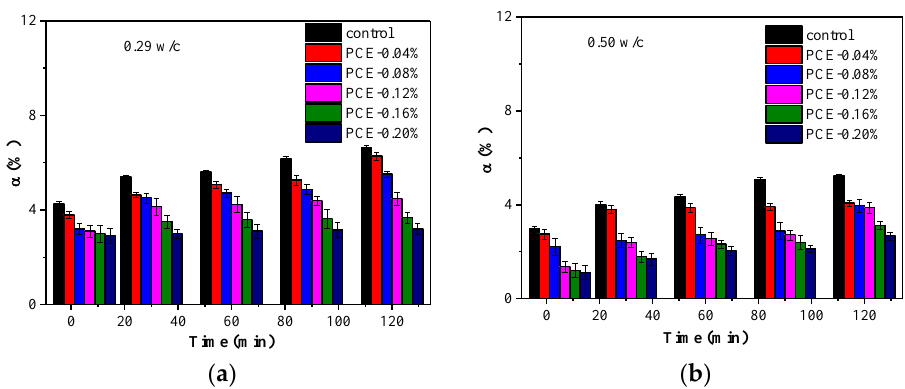
( b ) Figure 14. Calorimetry curves of cement pastes in the presence of PCEs at various dosages at 25 °C: ( a ) differential heat flow and ( b ) cumulative heat flow. 3.9. Chemically Bound Water The development of various products in hydrating cement pastes was quantified by chemically bound water. These results are shown in Figure 15. In Figure 15a,b, it shows that the chemically bound water of the solid phases in the fcps grows with hydration time. Additionally, higher bound water content in lower w/c pastes is observed, which reflects the higher product content in the lower w/c pastes during the early stages. This is partially due to a higher w/c causing a lower hydration ion contents in the cement solution, leading to a lower rate of hydration at early ages. Furthermore, it is clearly seen that the chemically bound water of the solid phases in the w/c = 0.29 fcps stays rather stable in the first two hours, while the hydrating in the w/c = 0.50 fcps rapidly grows with hydration time. Different evolutions of the chemically bound water were caused by different PCEs. Basically, the fcps containing PCEs show slow growth in chemically bound water, imply- ing retardation effect of the PCEs on cement hydration [32]. At w/c = 0.29, without the PCE, the ratio of bound water content was 6.64% after hydration of 2 h. In the presence of the PCE dosage of 0.2%, the ratio of bound water content decreased to 3.20%. Compared to two ratios of bound water content, it decreased by 51.8%. While at w/c = 0.50, without the PCE, the ratio of bound water content was 5.22% after hydration 2 h. In presence of